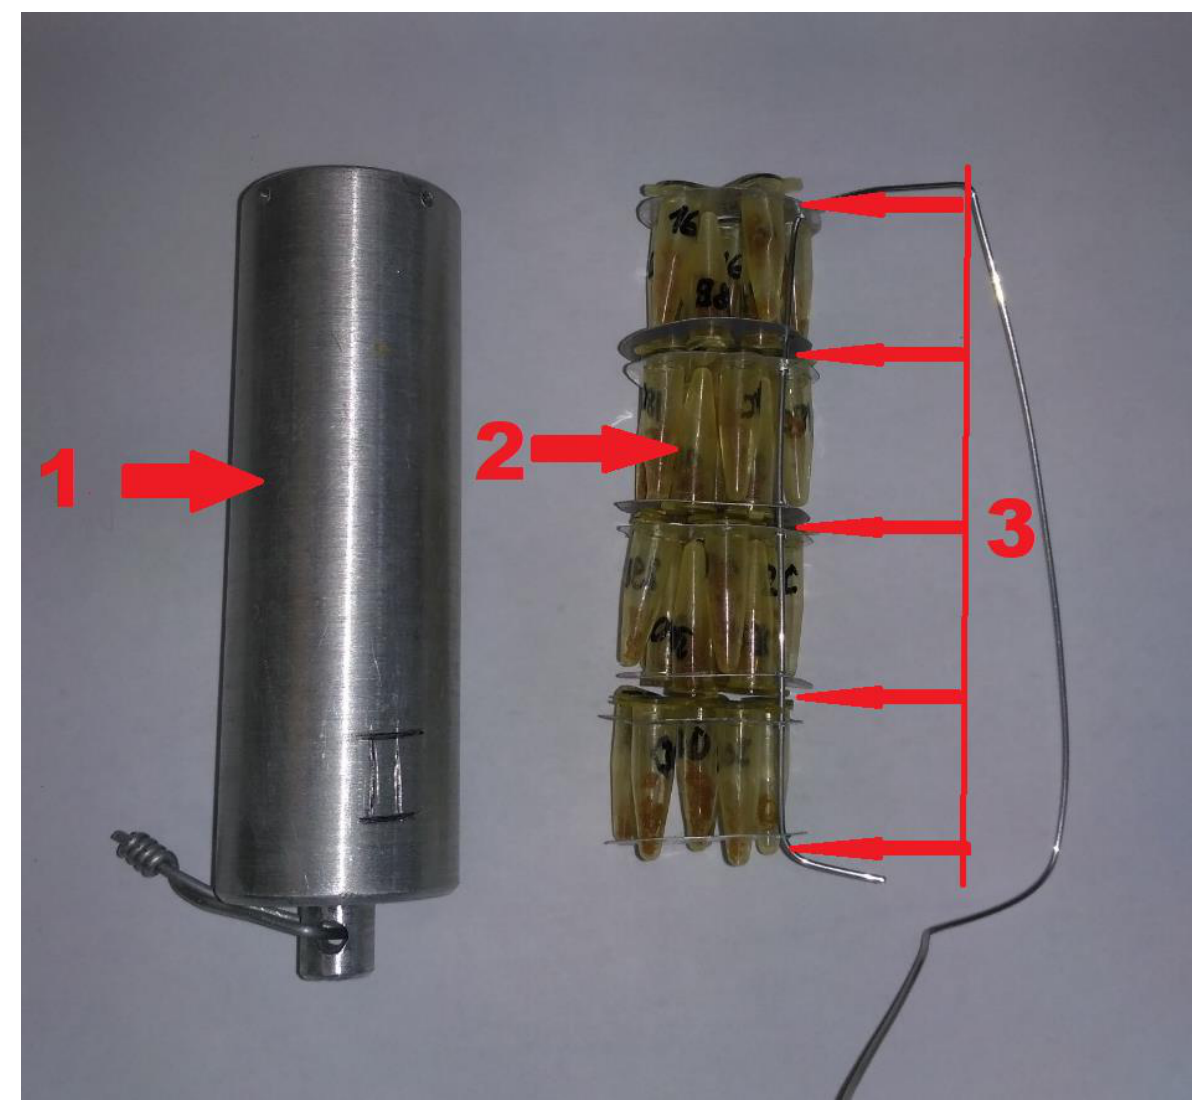
Figure 1. Apparatus for the neutron activation analysis (NAA). Aluminium case (1) on the left, experimental samples in plastic tubes (2) and paper gaskets with reference samples (3) on the right.